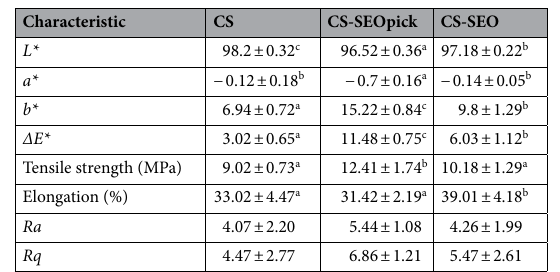
Table 1. Characteristics of developed films. CS chitosan, CS-SEOpick chitosan–sandalwood oil Pickering emulsion, CS-SEO chitosan–sandalwood oil regular emulsion films. Different letters indicate statistically significant differences at P < 0.05.